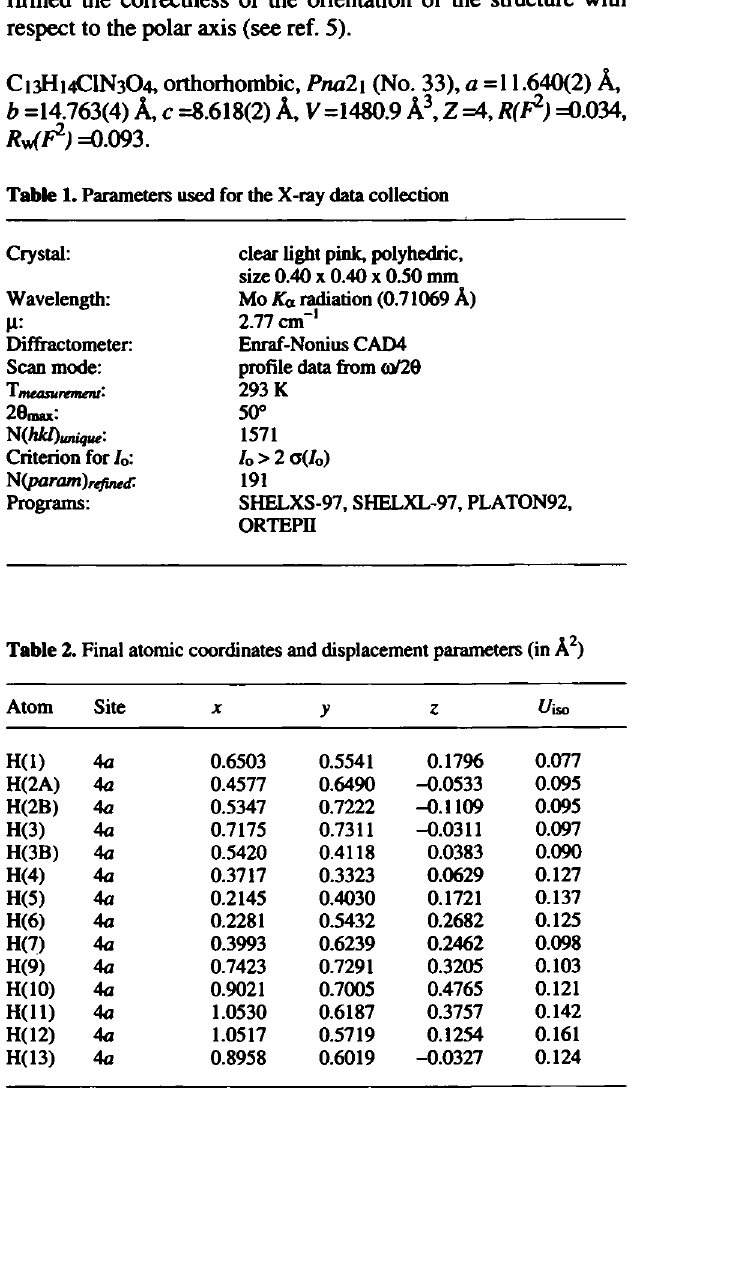
and O-CI-O angles are 1.403(7) Â and 109.4(7)°. The two ions are linked by a 3-dimensional network of hydrogen bonds: (ii) 1.5-jc, 0.5+y, z-0.5. Refinement of the Паск parameter con- firmed the correctness of the orientation of the structure with respect to the polar axis (see ref. 5). C13H14CIN3O4, orthorhombic, Pna2i (No. 33), a =11.640(2) A,